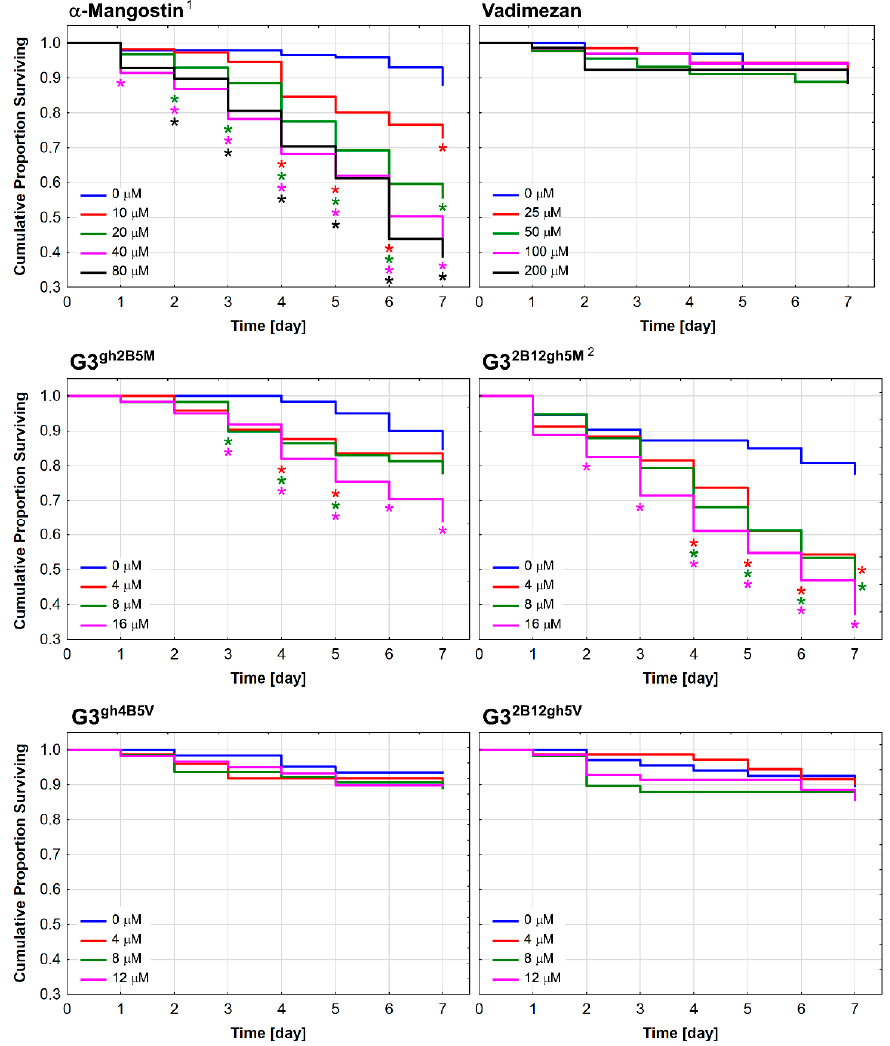
Figure 6. The Kaplan-Meier survival curves of C. elegans after 7 days of incubation with α M, V, G3 gh2B5M , G3 2B12gh5M , G3 gh4B5V or G3 2B12gh5V . Results are presented as cumulative proportion surviving. Statistically significant differences against dmso-treated control obtained in Gehan’s Wilcoxon test are marked with asterisks * ( p ≤ 0.05) in the colours corresponding to the tested concentrations. 1,2 Data for α M and G3 2B12gh5M conjugate were reproduced from [2] and [29], respectively. Table 3. The half maximal lethal concentration (LC 50 ) values estimated after 7 days incubation of C. elegans nematodes with free α M and V, or their dendrimer conjugates. Data are presented as medians with the first and third quartile. Presented values were calculated with AAT Bioquest IC 50 calculator [46].